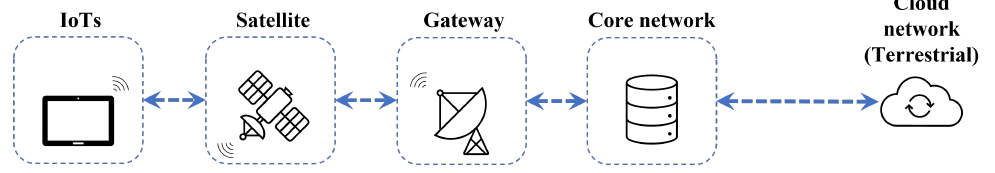
Figure 1. Illustration of the direct satellite access IoT network architecture.